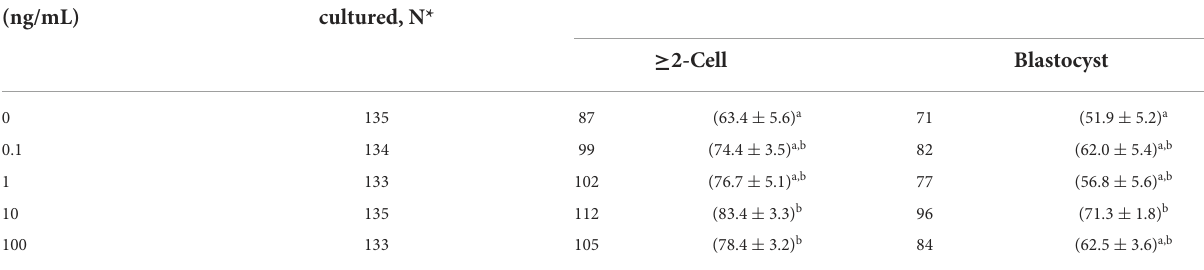
TABLE 1 Effect of IL-7 supplementation during IVC on embryonic development after PA.